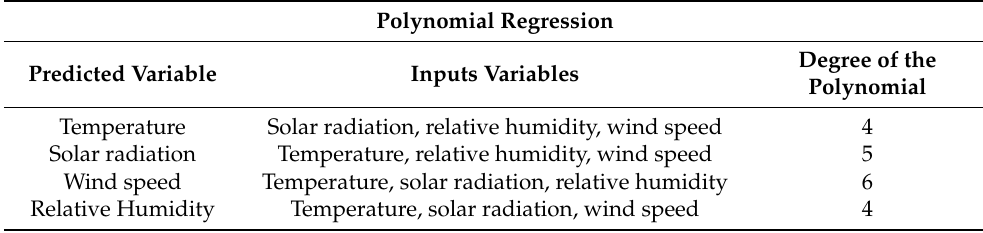
Table 2. Tuning parameters for polynomial regression technique.